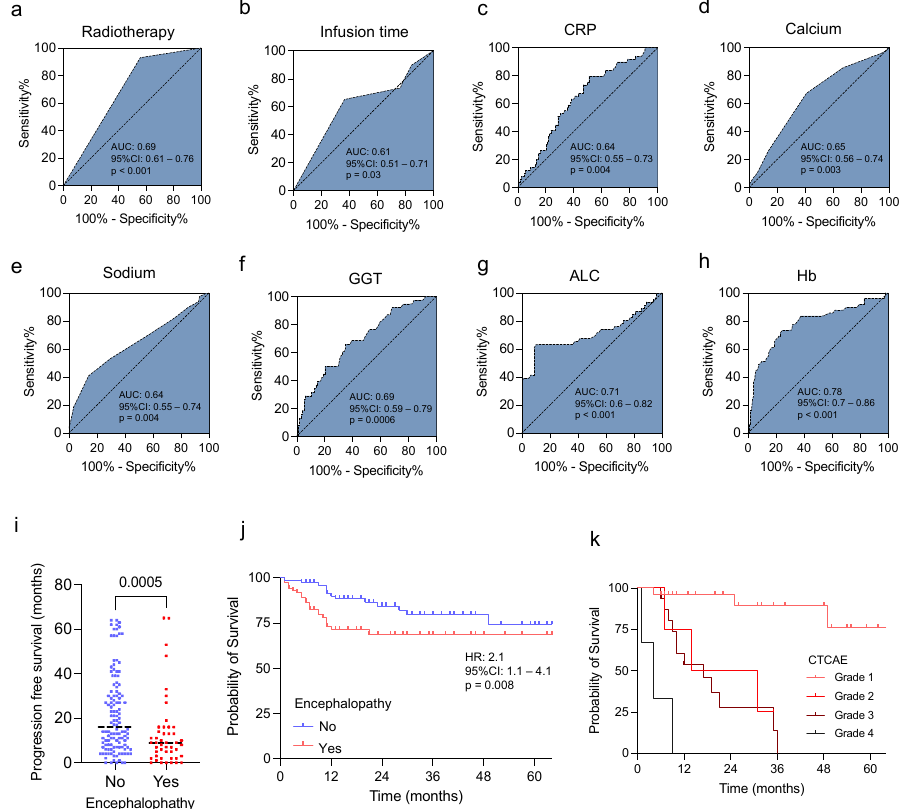
Figure 3. Predictive value of risk factors and influence of IIN on patient outcomes in STS. Predictive values of radiotherapy ( a ), ifosfamide infusion time ( b ), CRP ( c ), calcium ( d ), sodium ( e ), GGT ( f ), ALC ( g ), and Hb level ( h ) for the development of IIN were analyzed using ROC analysis. ( i ) Progression free survival in sarcoma patients with and without IIN. ( j ) Kaplan–Meier curve estimates of survival in sarcoma patients with and without IIN. ( k ) Kaplan–Meier curves showing the influence of CTCAE grade and probability of survival. IIN = ifosfamide-induced neurotoxicity; CRP = C-reactive protein; GGT = gamma-glutamyl transferase; ALC = Absolute lymphocyte count; Hb = hemoglobin level; ROC = receiver operator characteristic; CTCAE = Common Terminology Criteria for Adverse Events.